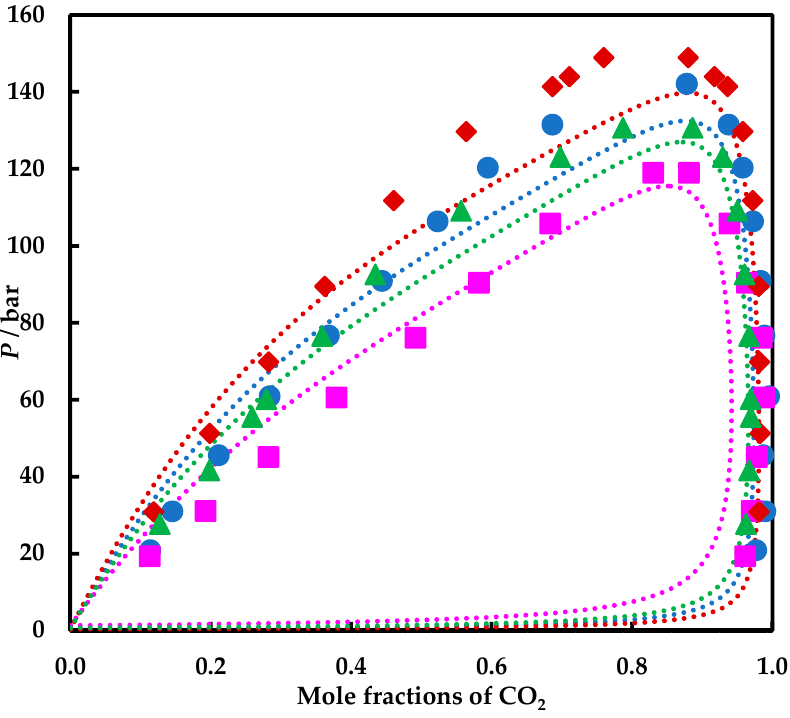
Figure 9. Comparison of experimental data (symbols) for carbon dioxide + 1-butanol, + 2-butanol, + isobutanol, and + tert -butanol and predictions (dotted lines) by PR EoS ( k 12 = 0.025; l 12 = − 0.108).